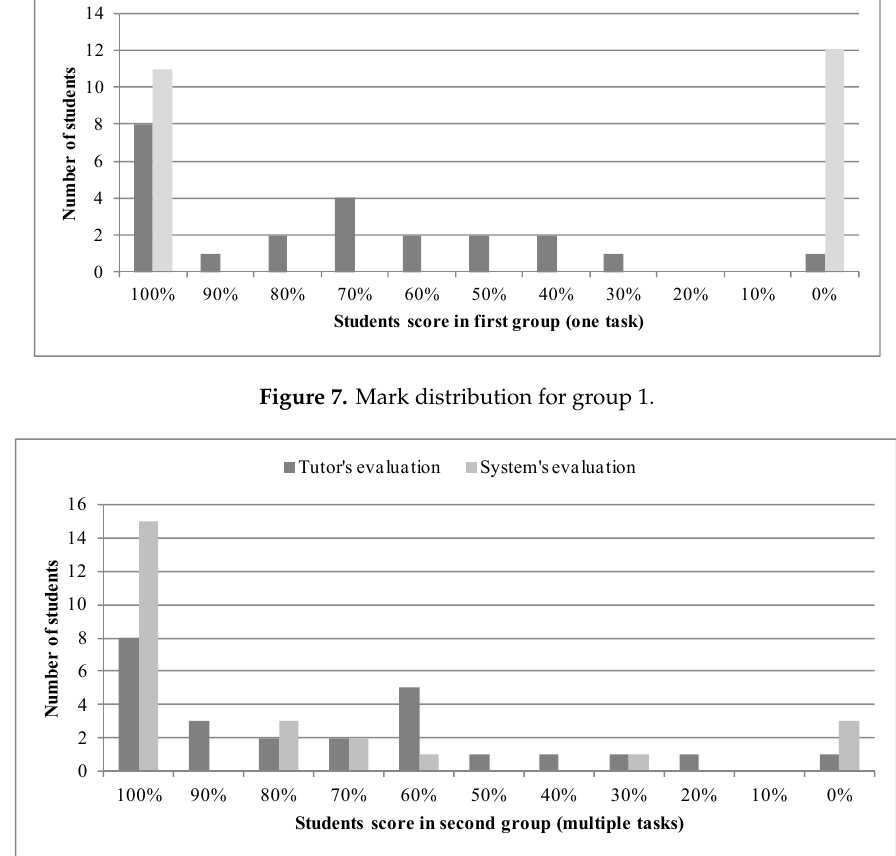
Figure 8. Mark distribution for group 2.